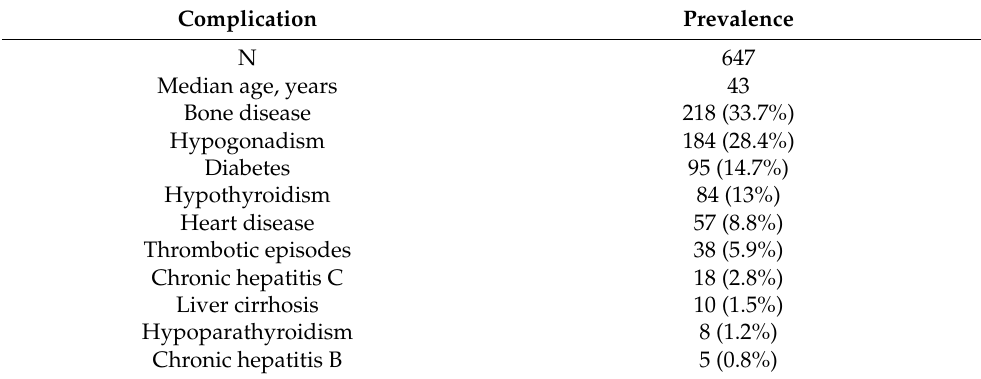
Figure 1. Age distribution of patients with β -thalassaemia in Cyprus. Table 2. Prevalence of complications in a Cypriot cohort of β -thalassaemia patients.